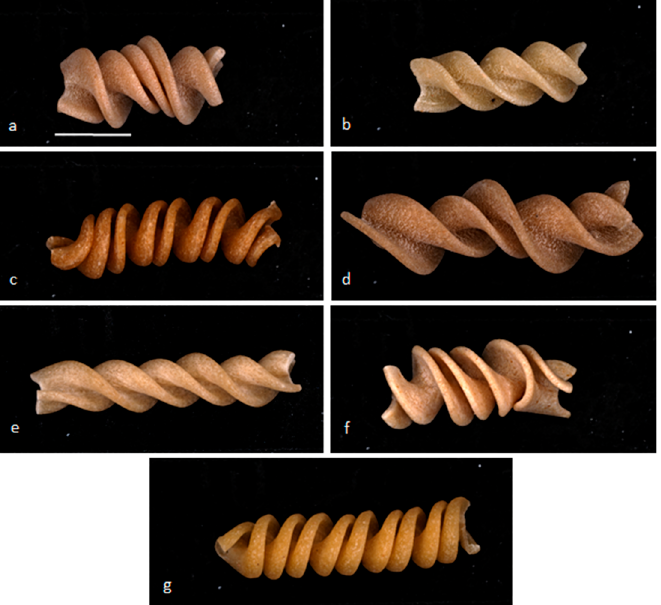
Figure 2. Diversity of shape and appearance of different brands of fusilli pasta: photographs of ( a ) pasta 1, ( b ) pasta 2, ( c ) pasta 3, ( d ) pasta 4, ( e ) pasta 5, ( f ) pasta 6, and ( g ) pasta 7 (white bar = 1 cm). In terms of L*, a*, b* characteristics (Table 2), the brightness (L*) of the pasta ranged from 66.88 to 75.78. Samples 2 and 7 were brighter, samples 3 and 4 darker, and samples 1, 5, and 6 intermediate. The redness (a*) component ranged from 2.03 to 4.76 and none of the pasta samples were similar in this respect. Yellowness (b*) ranged from 19.66 to 24.22, with samples 3 and 7 being the most yellow and samples 1 and 2 being the least yellow. The highest YI was measured in pasta 3 and the lowest in pasta